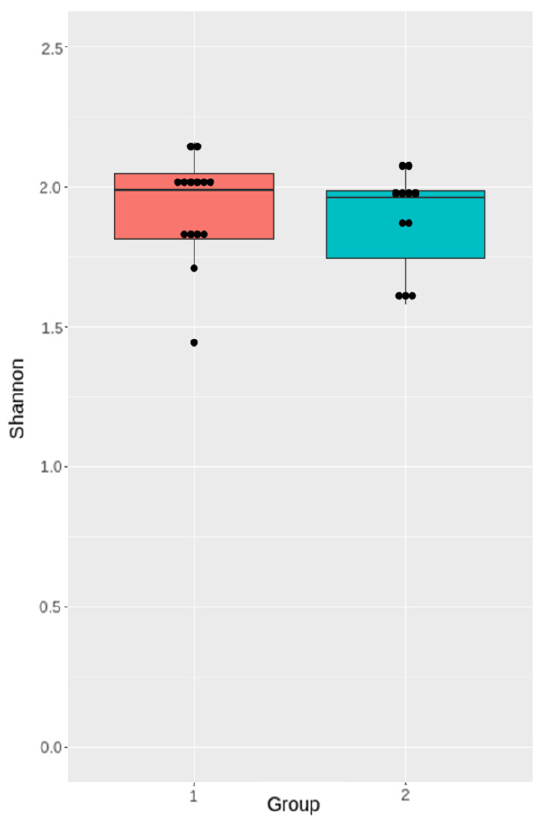
Figure 12. Shannon diversity indices of the pre-TBI gut microbiota in Group 1 and Group 2.